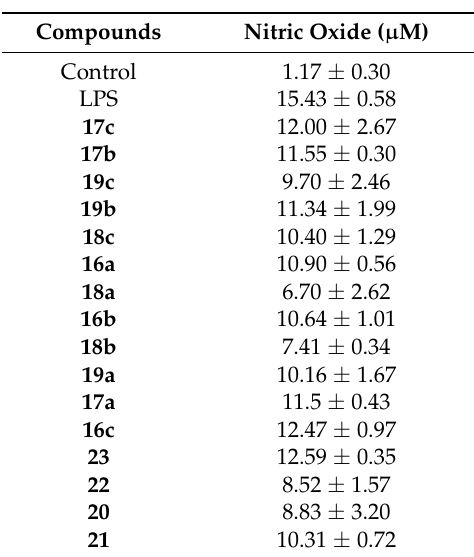
Table 1. Effects of 2-substituted 3-arylquinoline derivatives on NO production by LPS-activated J774A.1